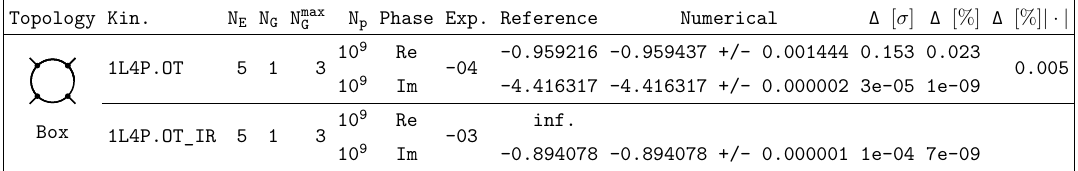
Table 6. Two forward scattering configurations of a one-loop box integral featuring raised threshold singularities. The latter features a soft singularity, which results in a divergence in the real part. The reference results were calulated with Package-X